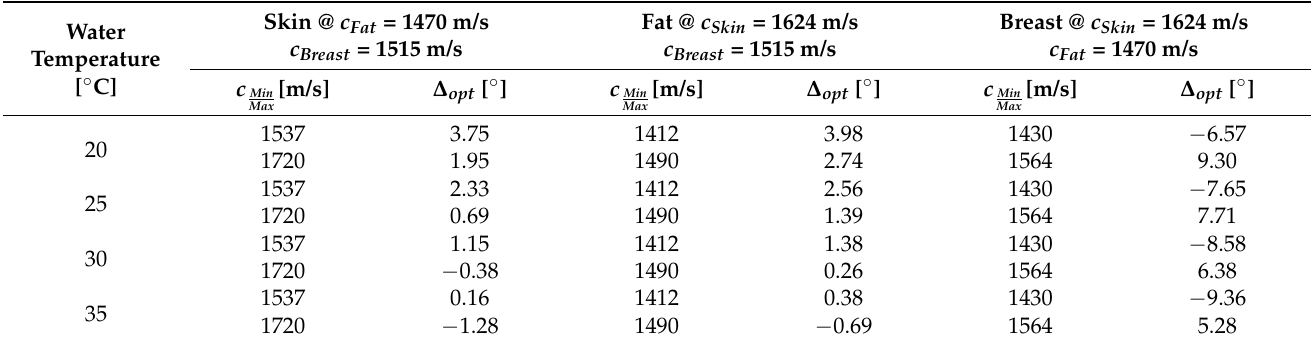
Table 1. Values of the ∆ opt parameter calculated for selected minimum and maximum ultrasound velocity in skin, fat, and breast glandular